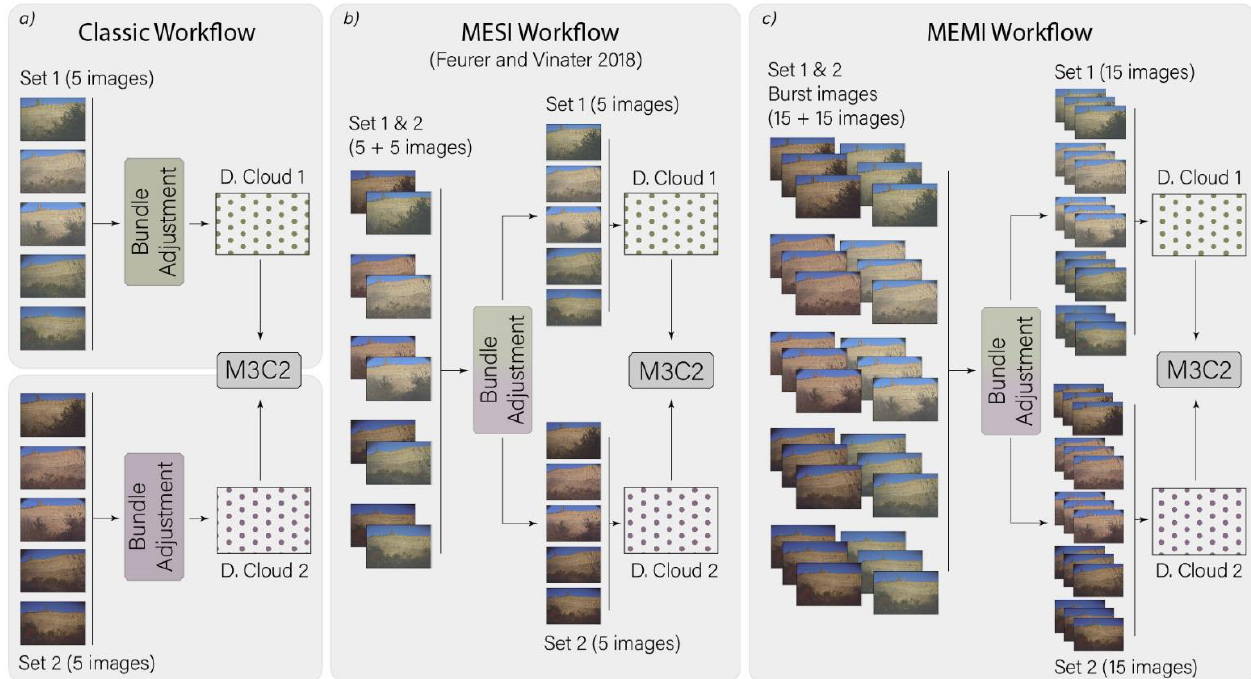
Figure 4. Three different SfM photogrammetry workflows to calculate multi-temporal point clouds for change detection. The colour shading denotes images obtained at different time epochs. ( a ) The classic workflow corresponds to the standard SfM photogrammetric approach. ( b ) The multi-epoch imagery workflow (MESI) adopts the method defined by Feurer and Vinatier [25], i.e., joining images from multi-epochs during image matching and bundle adjustment. ( c ) The Multi-Epoch Multi-Imagery (MEMI) workflow considers (additionally to b) redundant image bursts from each epoch.